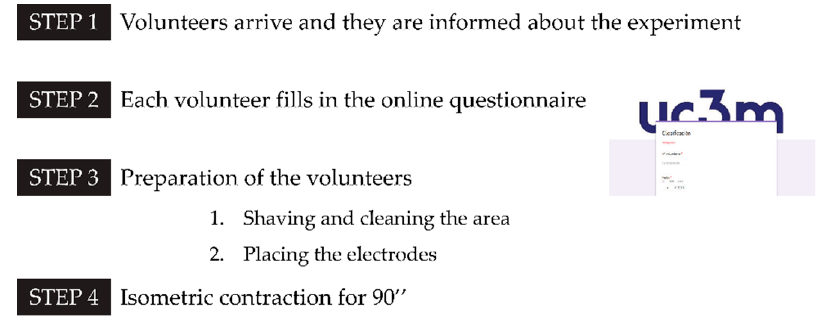
Figure 3. Steps of the experiment and a short explanation of them.